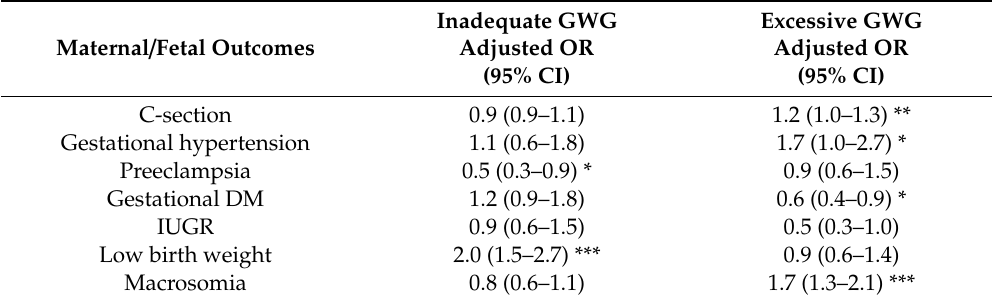
Table 4. The relationships among GWG (IOM recommendations) and selected maternal / fetal outcomes (multiple logistic regression